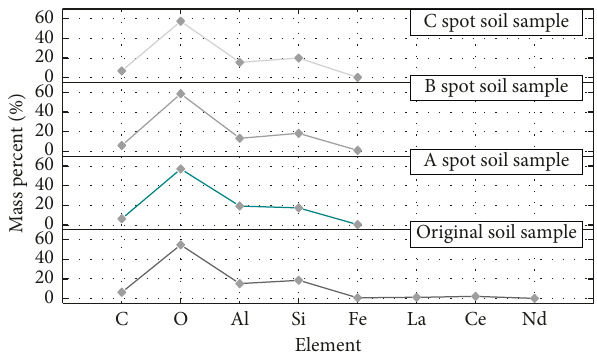
Figure 7: Elemental mass percent distribution.